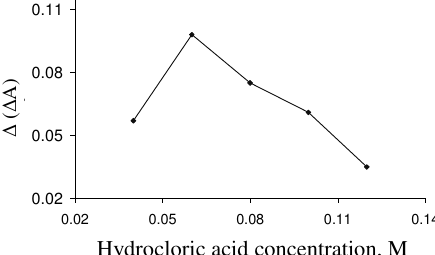
Figure 3. Influence of HCl concentration on the analytical signal, conditions: Methyl red 3.7 × 10 -5 M; BrO 3- 2 × 10 -4 M; CTAB 2.6 × 10 -3 M ; phenylhydrazine, 0.1 µ g/mL; temperature 27 °C